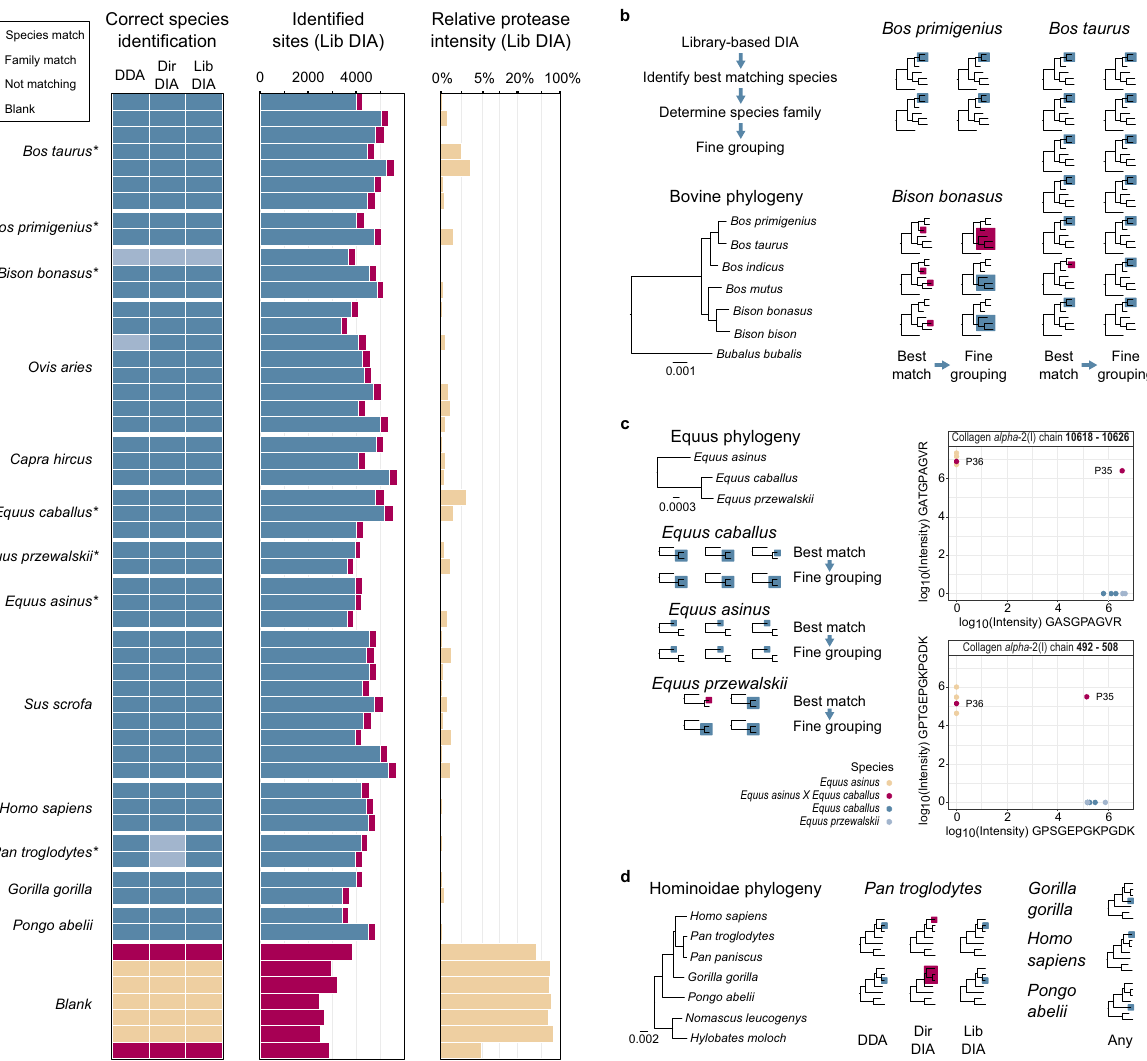
Fig. 3 Reference species analysis. a Species identi fi cation results based on DDA, directDIA, and library-based DIA analysis. Dark blue boxes indicate correct identi fi cation of a single or multiple indistinguishable (marked by asterisk) species. Light blue indicates species that could not be separated from their closest relatives. Blanks that were below the relative protease intensity threshold are shown in pink. The “ identi fi ed sites ” bar chart shows the absolute amino acid coverage in blue for sites matching the true species and pink for non-matching sites. The relative protease intensity was calculated by dividing the intensity of protease peptides by total intensity and plotted in log-scale. b Bovine species identi fi cations obtained by library-based DIA analysis. Phylogeny was based on the protein database. Correctly identi fi ed single or indistinguishable species are highlighted in blue. Inconsistent identi fi cations are marked in pink. Best Matching species are on the left and the re fi ned “ fi ne-grouping ” on the right side. c Same display as in b for equine species analyzed by library-based DIA data. The additional plots on the right side show the log10 intensity of two species-discriminating peptides for the horse isoform on the x - axis and the donkey isoform on the y -axis. Missing quanti fi cations are shown as zero log10 intensity. Donkey samples are marked in sand color, horse in dark blue, Przewalskii horse in light blue, and hybrids pink. d Species identi fi cations after fi ne-grouping for great apes comparing the three different peptide identi fi cation strategies. Correctly identi fi ed genus is highlighted in blue. Broader matches within the family are marked in pink. Differences between the three identi fi cation strategies were only observed for the genus Pan